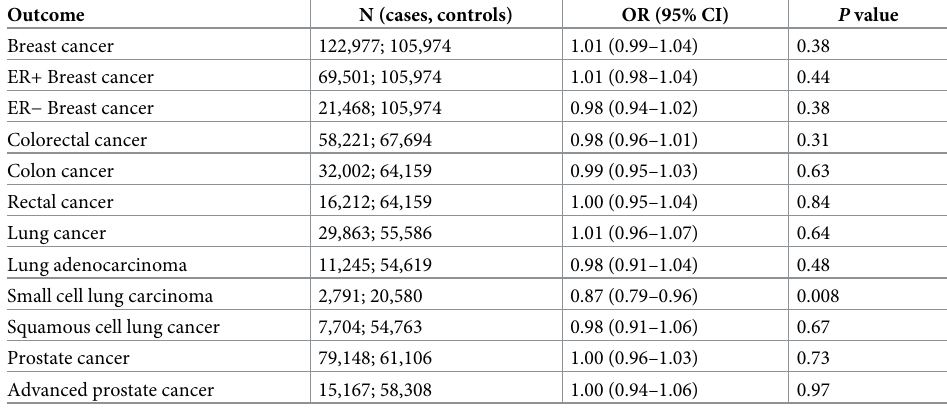
Table 3. Association between genetically proxied ADRB1 inhibition and risk of overall and subtype-specific breast, colorectal, prostate, and lung cancer risk. Outcome N (cases, controls) OR (95%